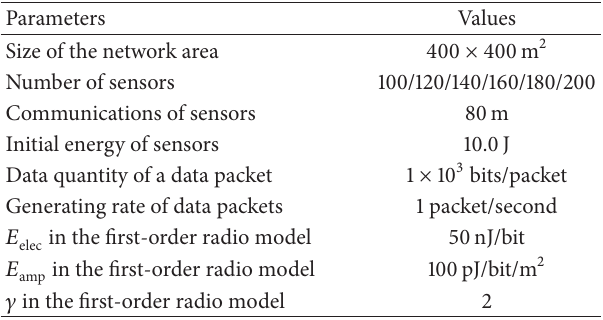
Table 1: The values of the main simulation parameters.